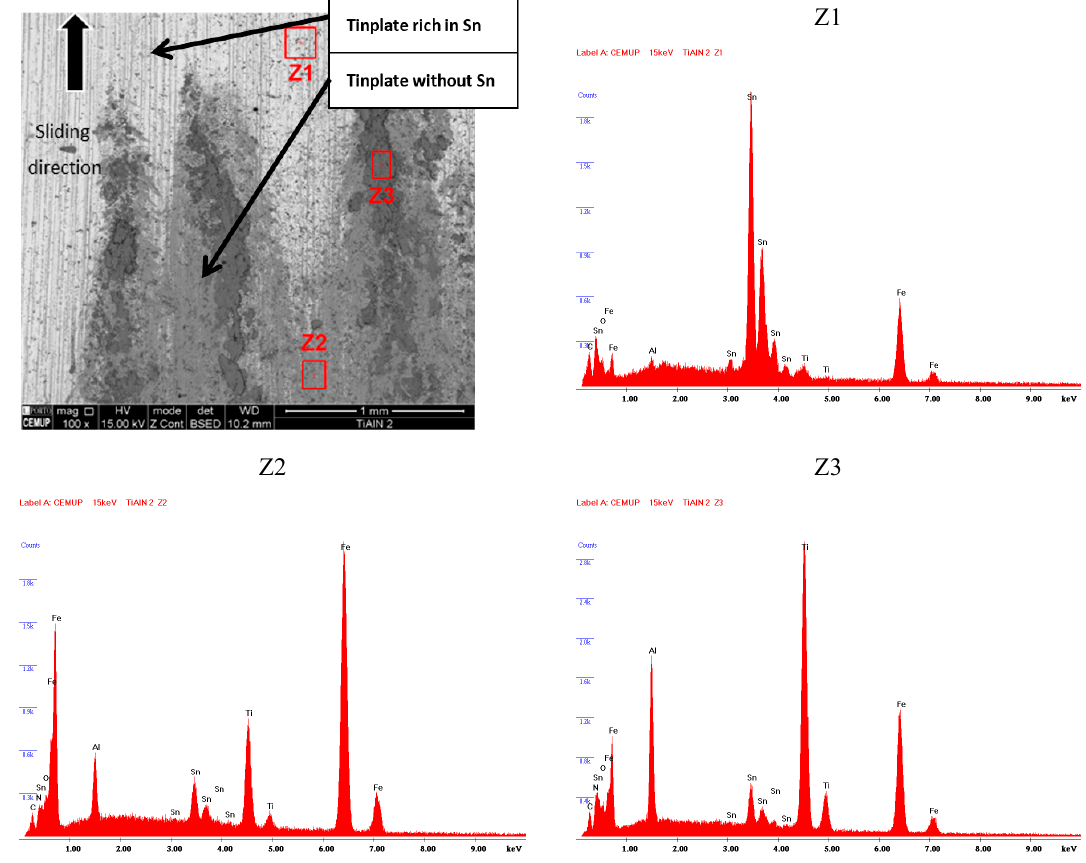
Figure 12. Spectrum of the TiAlN surface at area Z1.